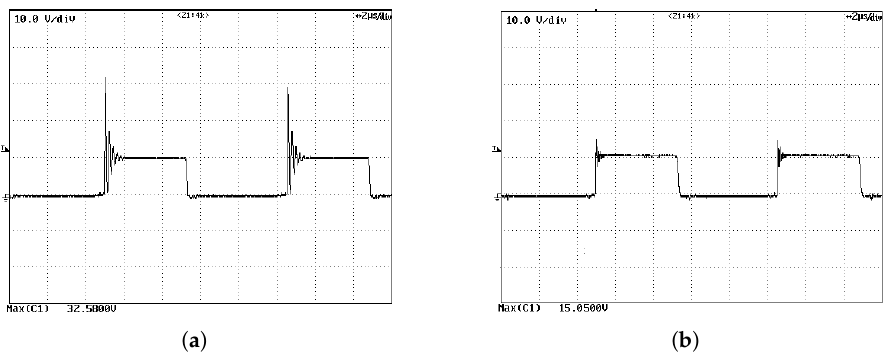
Figure 11. Voltage waveforms of the rectifier tube. ( a ) Without saturable inductors; ( b ) With sat- urable inductors.